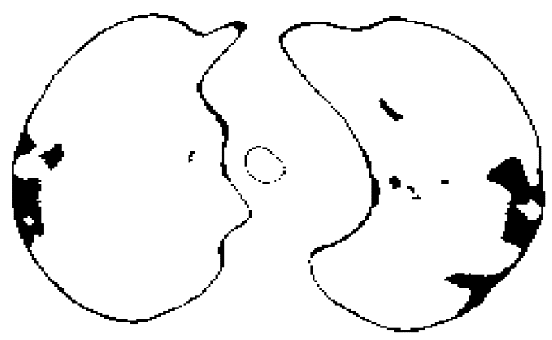
Figure 4. Binary image after using a median filter kernel size 10 × 10.